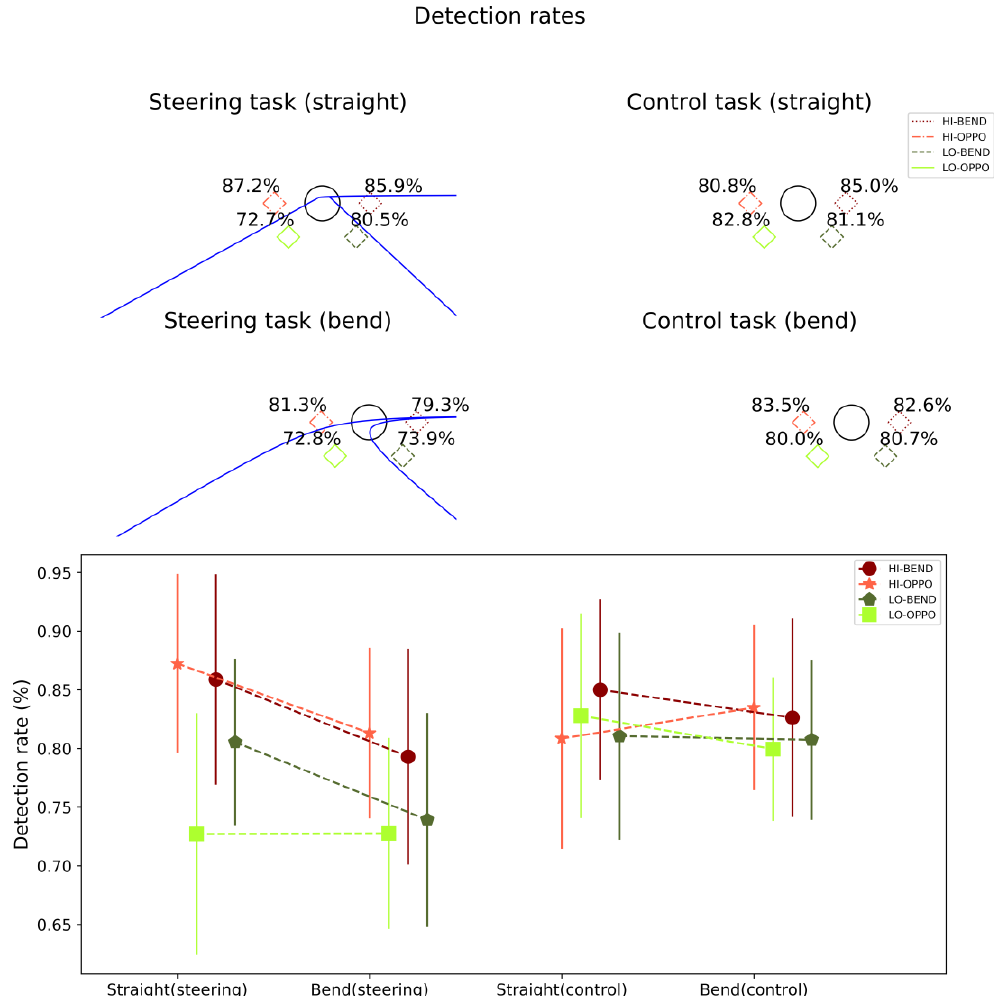
Figure 7. Top. Mean detection ratios for targets presented in the different target locations, in the steering and control tasks and on the straights and in the bends. Bottom. The mean detection rates and standard deviations in a line plot.